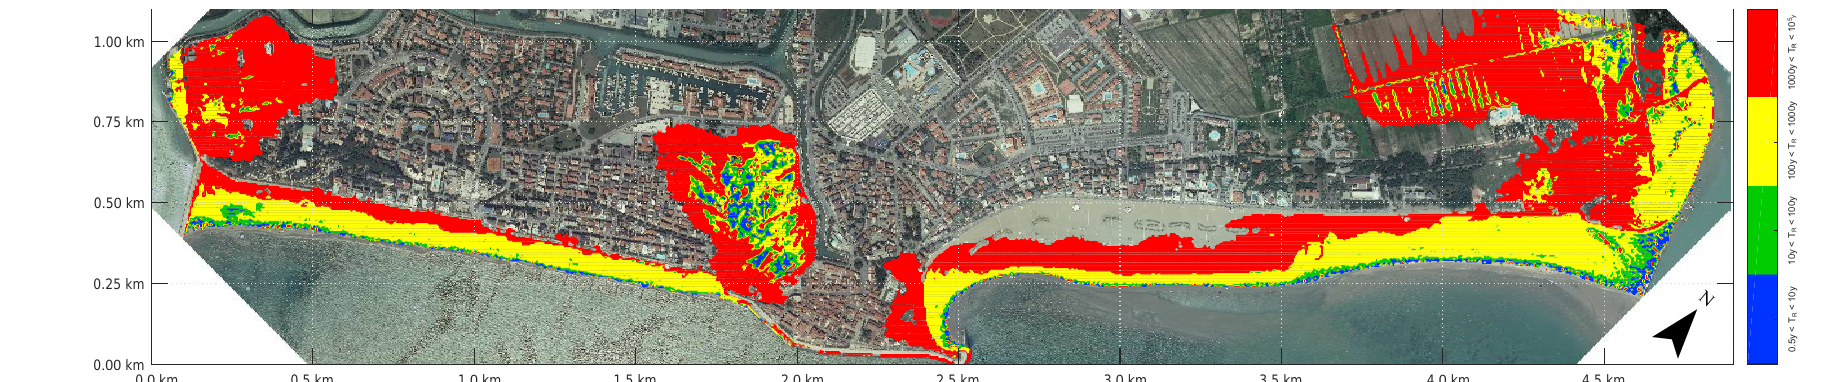
Figure 13. Hazard map (cell VE3): Probability that flooding level 0.5 m is exceeded, expressed as return period T R